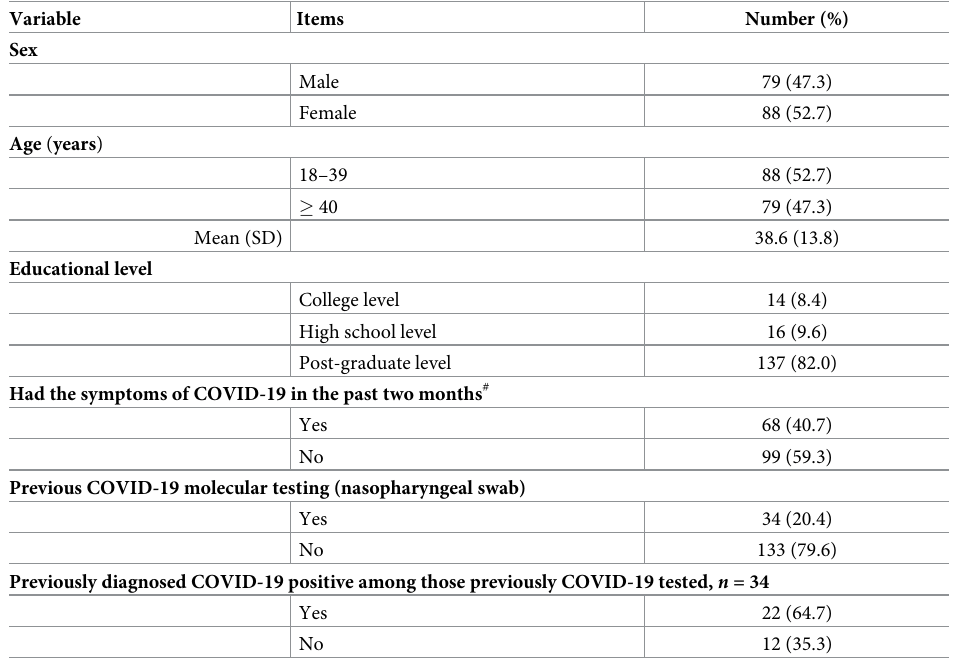
Table 1. The demographic characteristics and medical history of the 167 study